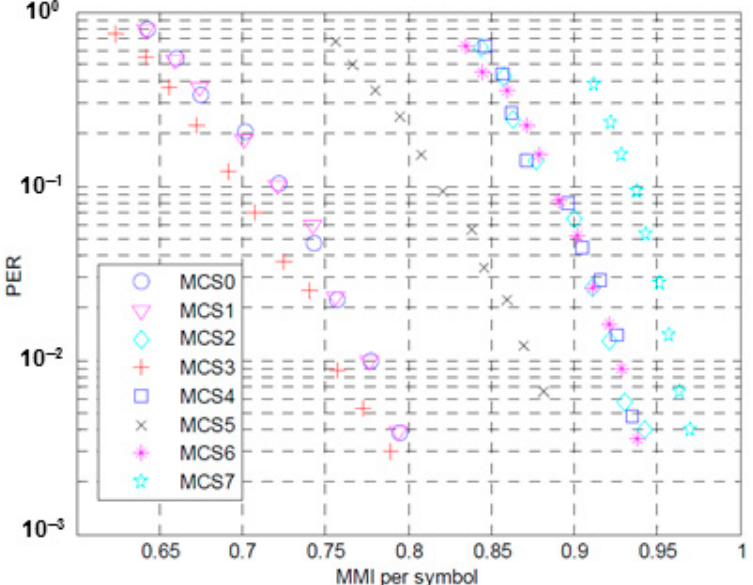
Figure 6. Mean mutual information (MMI)-to- packet error rate (PER) conversion for MCS 0–7.